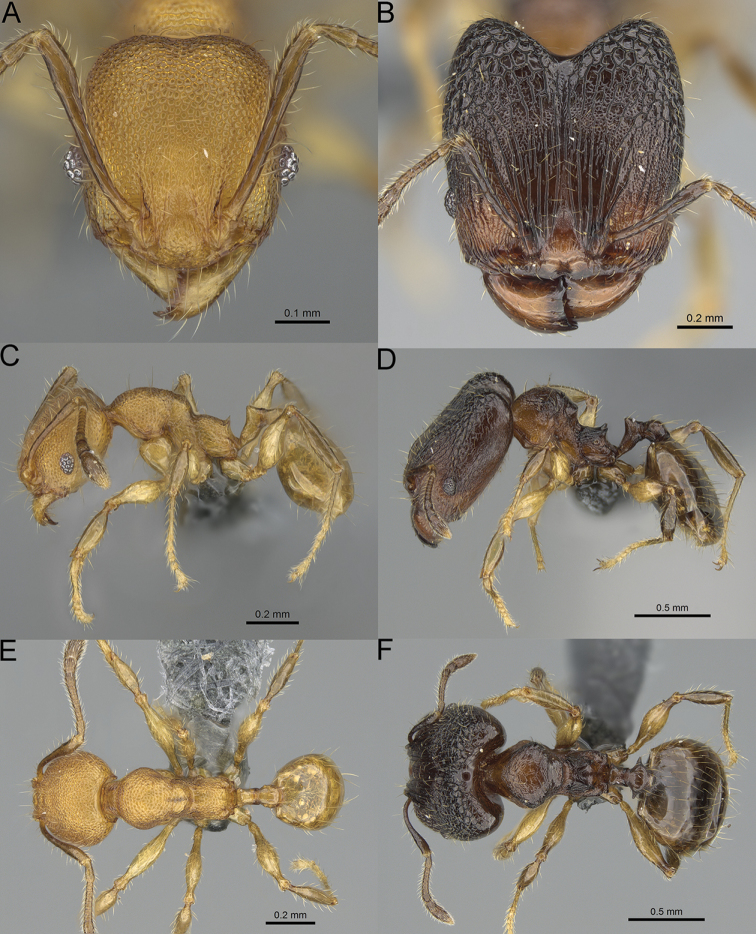
Pheidole
madinika sp. nov., full-face view (A), profile (C), and dorsal view (E) of paratype minor worker (CASENT0923166) and full-face view (B), profile (D), and dorsal view (F) of holotype major worker (CASENT0808089).